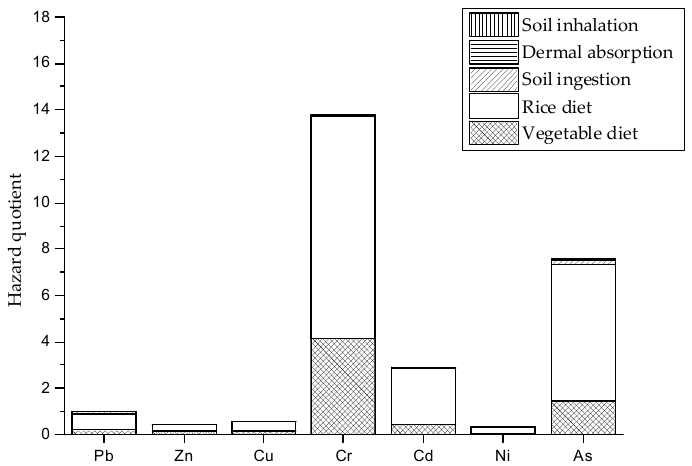
Figure 6. The hazard quotient of heavy metals via different pathways.